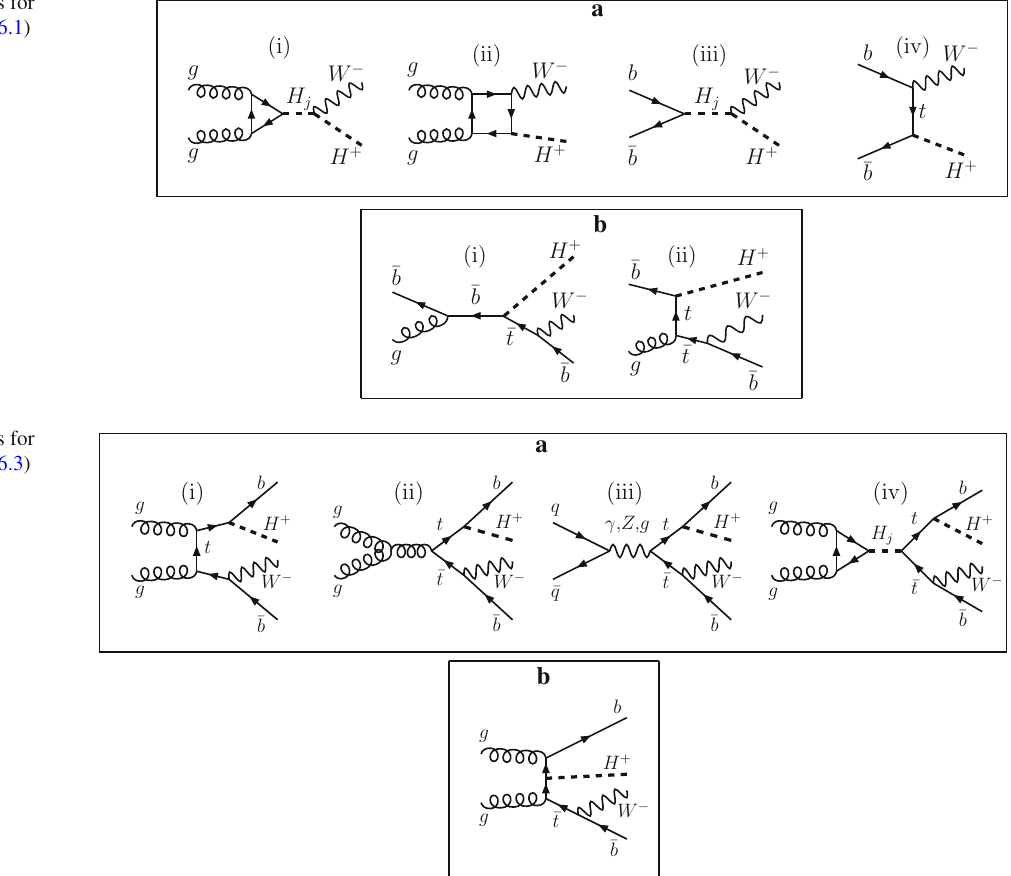
Fig. 8 Feynman diagrams for the production processes